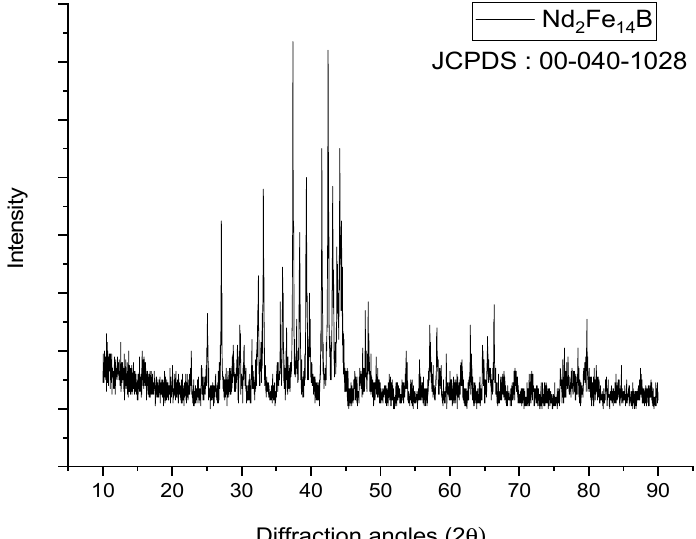
Figure 3. XRD pattern of NdFeB magnet powders.